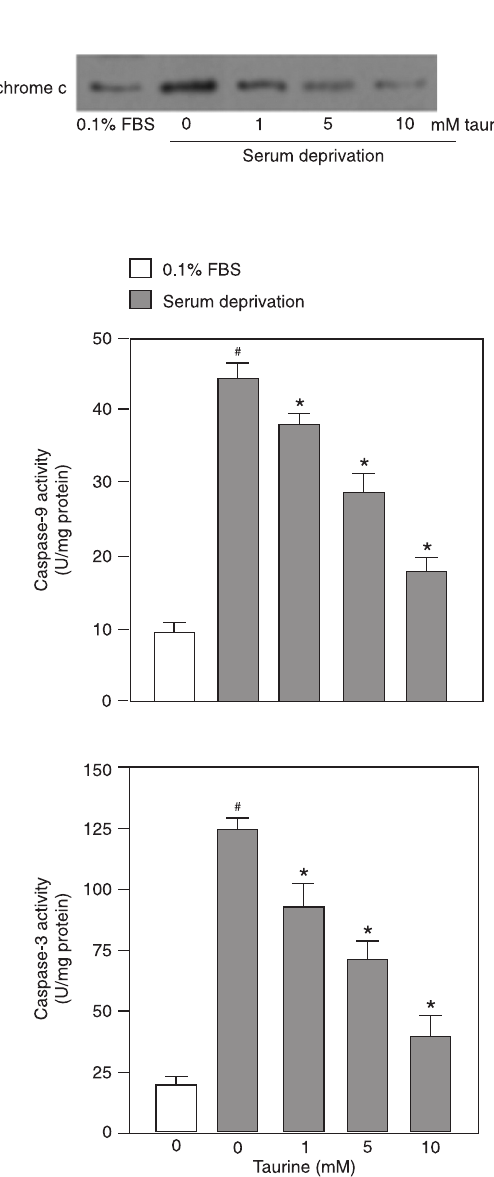
Figure 2. Effects of taurine on cytochrome c release and cas- pase-3 and -9 activation in serum-deprived MC3T3-E1 cells. A , Western blot analysis of the effect of taurine on cytochrome c re- lease. Cells were grown in the absence or presence of 0.1% FBS in α-MEM for 24 h and serum-deprived cells were treated with vehicle or 1 to 10 mM taurine for 24 h. Representative results are shown. B , Fluoro-substrate assays of the effects of taurine on serum deprivation-induced activation of caspase-3 and -9. Cells were grown in the absence or presence of 0.1% FBS in α-MEM for 1.5 h and serum-deprived cells were treated with vehicle or 1 to 10 mM taurine for 1.5 h. One unit (U) was defined as the amount of enzyme required to release 1 μM 7-amino-4-methyl - coumarin (AMC) per hour at 37°C. The bars indicate the mean ± SD (N = 5). # P < 0.05 vs 0.1% FBS-treated control; * P < 0.05 vs vehicle-treated serum-deprived group (one-way